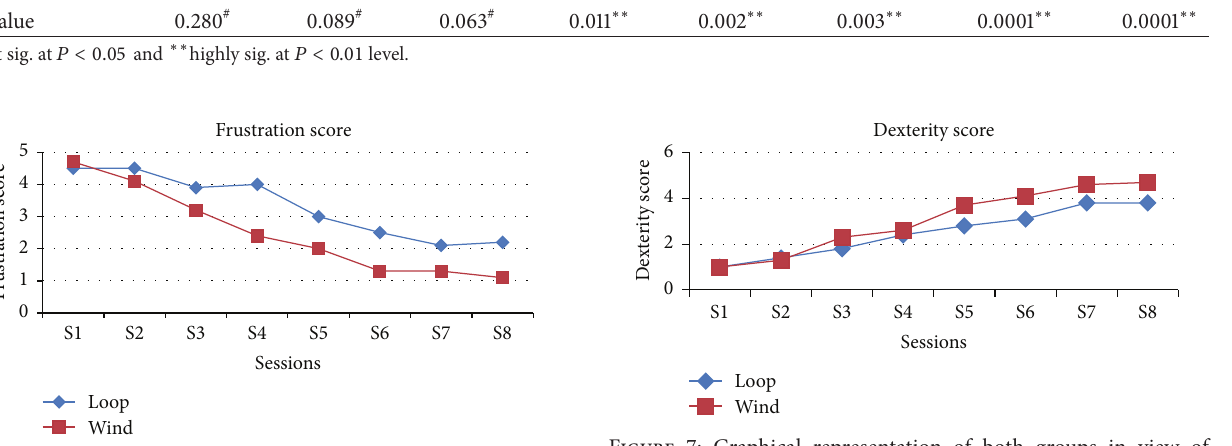
Figure 5: Graphical representation of both groups in view of frustration in the end of each session.